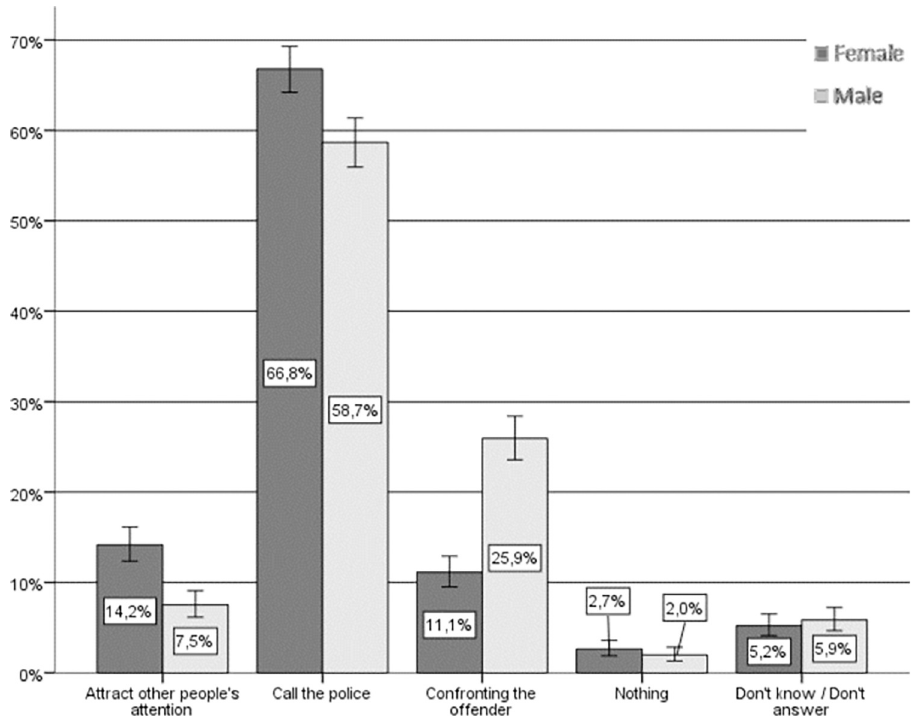
Fig 2. Hypothetical response to IPVAW, by sex. Source: Own elaboration based on CIS study 2968 [43], question 14. 95% confidence intervals are provided for each subsample.